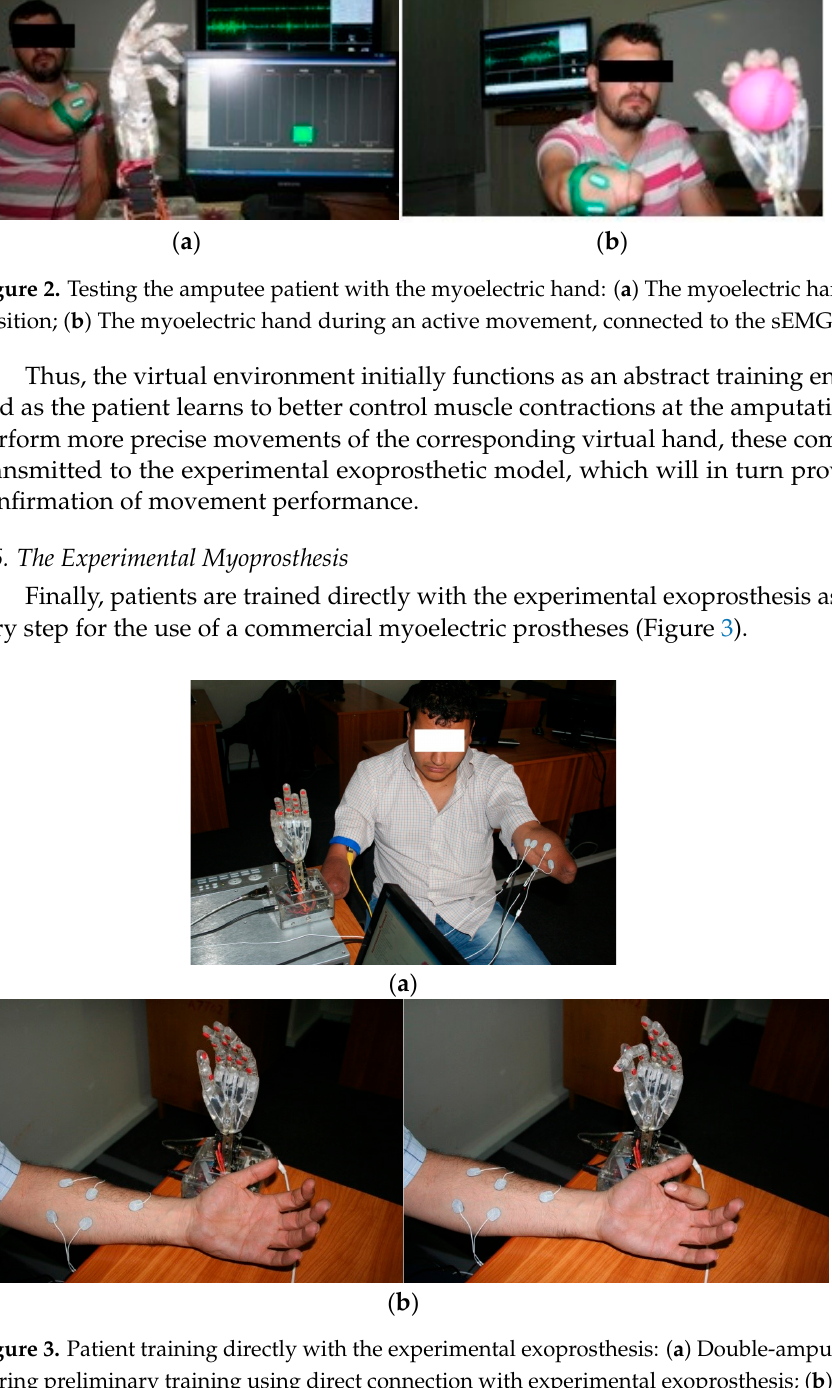
Figure 2. Testing the amputee patient with the myoelectric hand: ( a ) The myoelectric hand in rest- ing position; ( b ) The myoelectric hand during an active movement, connected to the sEMG re- ceiver.